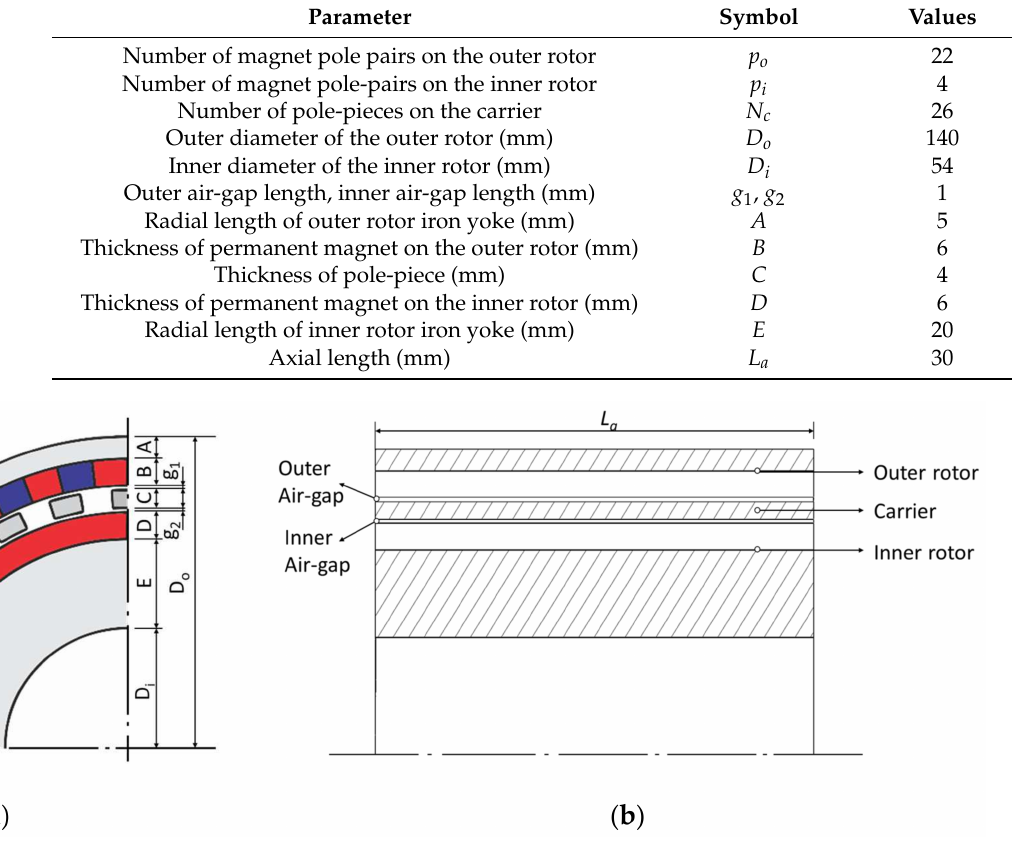
Figure 3. Design parameters of the CMGT: ( a ) Sectional view; ( b ) Axial